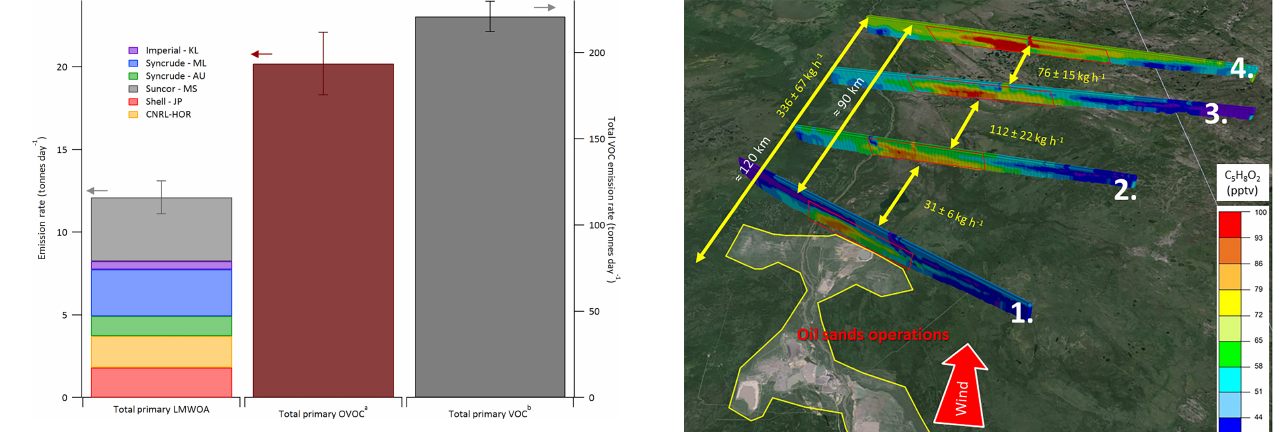
Figure 5. Total daily primary LMWOA emitted in the oil sands (this study, left axis) compared to recently reported total primary VOC (right axis) and total primary oxygenated VOC emissions (left axis). (a) As reported in Li et al. (2017). Panel (b) includes oxygenates as reported in Li et al. (2017).